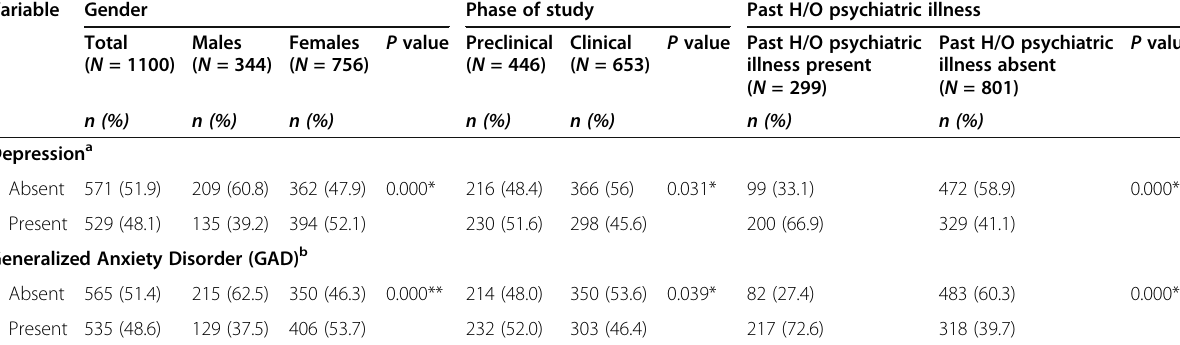
Table 2 Prevalence of depression and anxiety among medical students during the COVID-19 outbreak (total N = 1100)